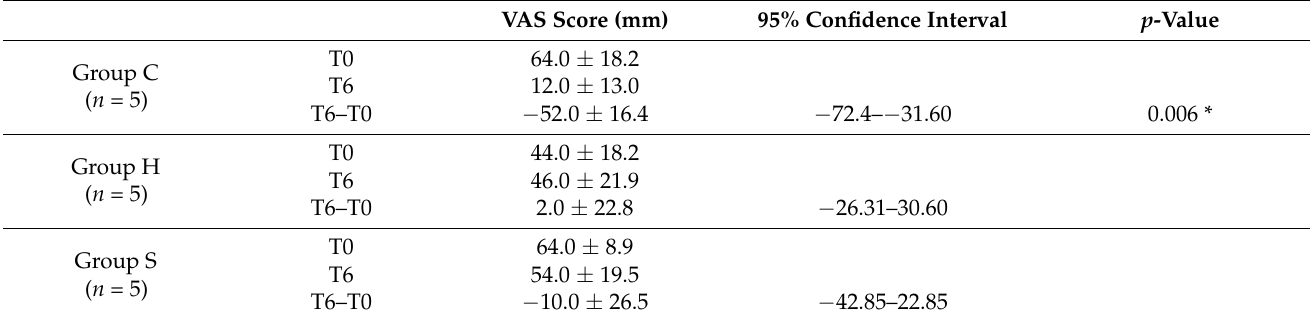
Table 2. Weight-bearing pain in all